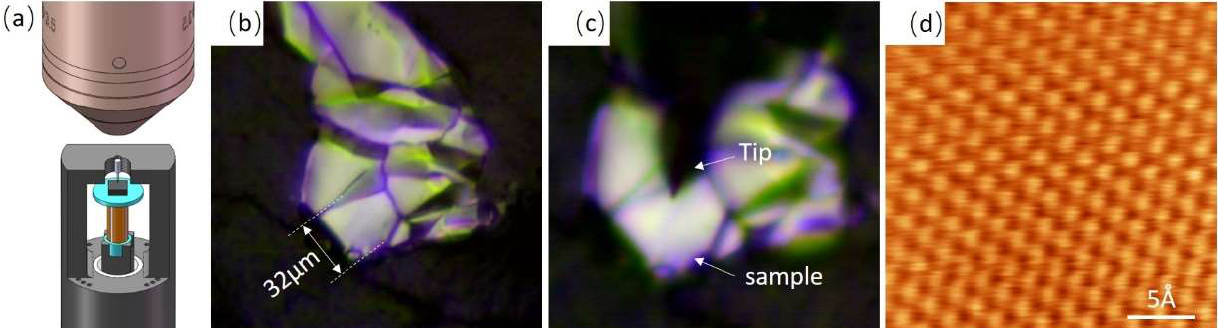
Figure 5. ( a ) Three-dimensional schematic diagram of the positioning process. ( b ) Optical micro- scope photograph of the small-sized graphite flake before the positioning process. ( c ) Optical microscope photograph obtained after the positioning process. ( d ) Atomic resolution image obtained on micron-sized sample with constant height mode; the average tunneling current is 12.5 nA, and the scan speed is 10 lines/s.